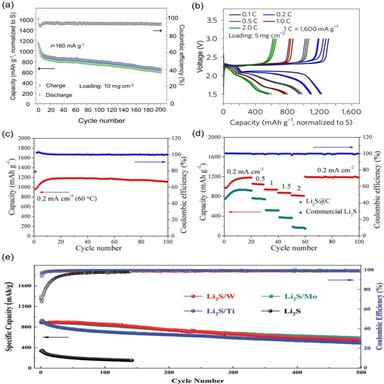
(a) Cycling performance of the Li2S@graphene electrode based on electrode loading of 10 mg Li2 S=cm2 via the reaction between Li and CS2 gas. (b) Voltage profiles of the Li2S@graphene electrode at different charge/discharge current densities via the reaction between Li and CS2 gas. (c) Cycling performance at 0.2 mA/cm2 of the Li2S@C nanocomsposite in ASSLSBs with areal Li2S loading of 1.75 mg Li2 S=cm2 at 60 C via the reaction between Li and CS2 liquid. (d) Rate performance under different cu